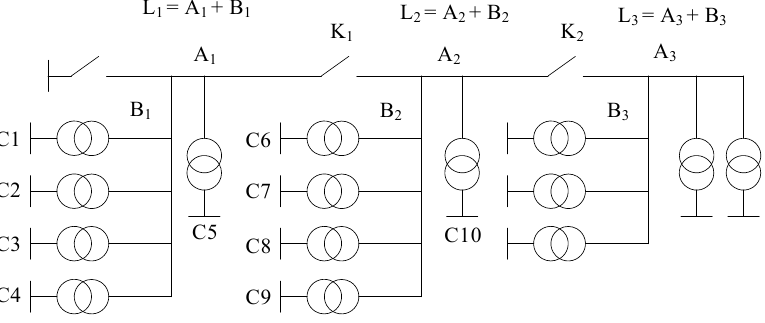
Figure 2. Line segmentation